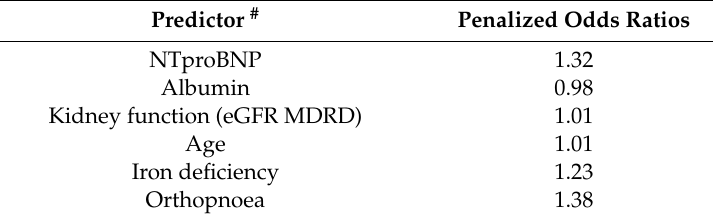
Table A4. Results of LASSO penalized regression.